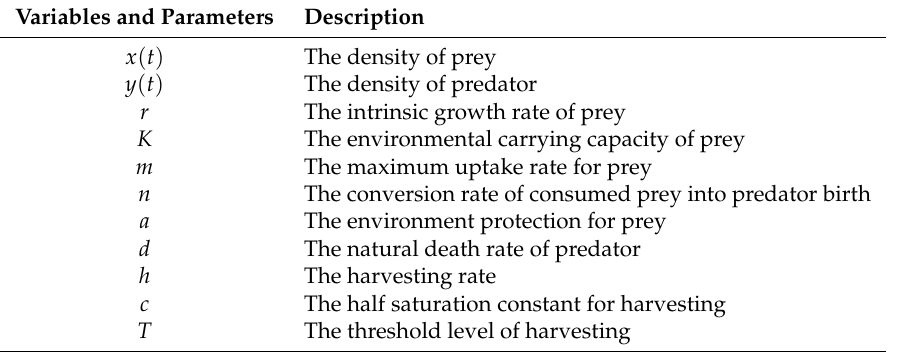
Table 1. Description of variables and parameters of the model